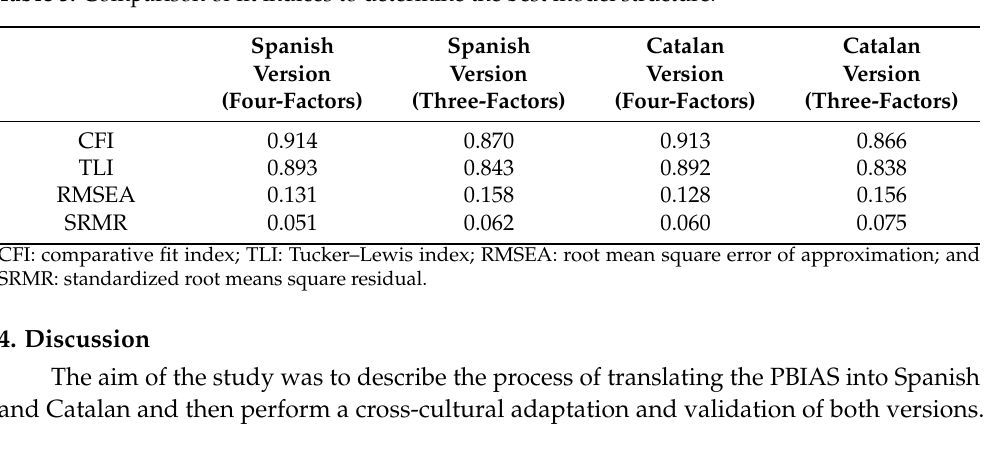
Table 5. Comparison of fit indices to determine the best model